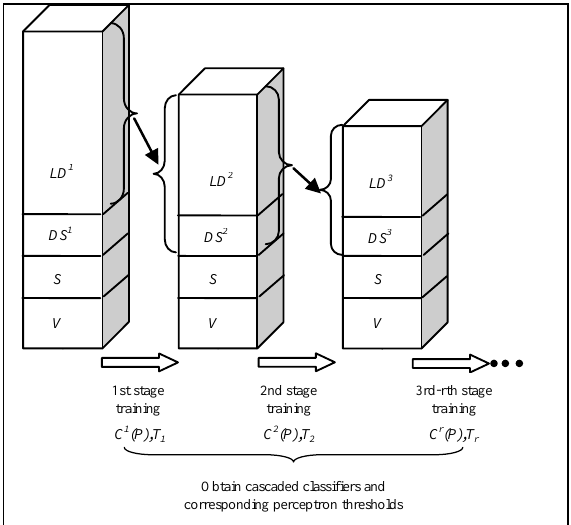
Fig. 3. Multi-stage cascaded training from large dissimilar, similar, initial dissimilar and validation